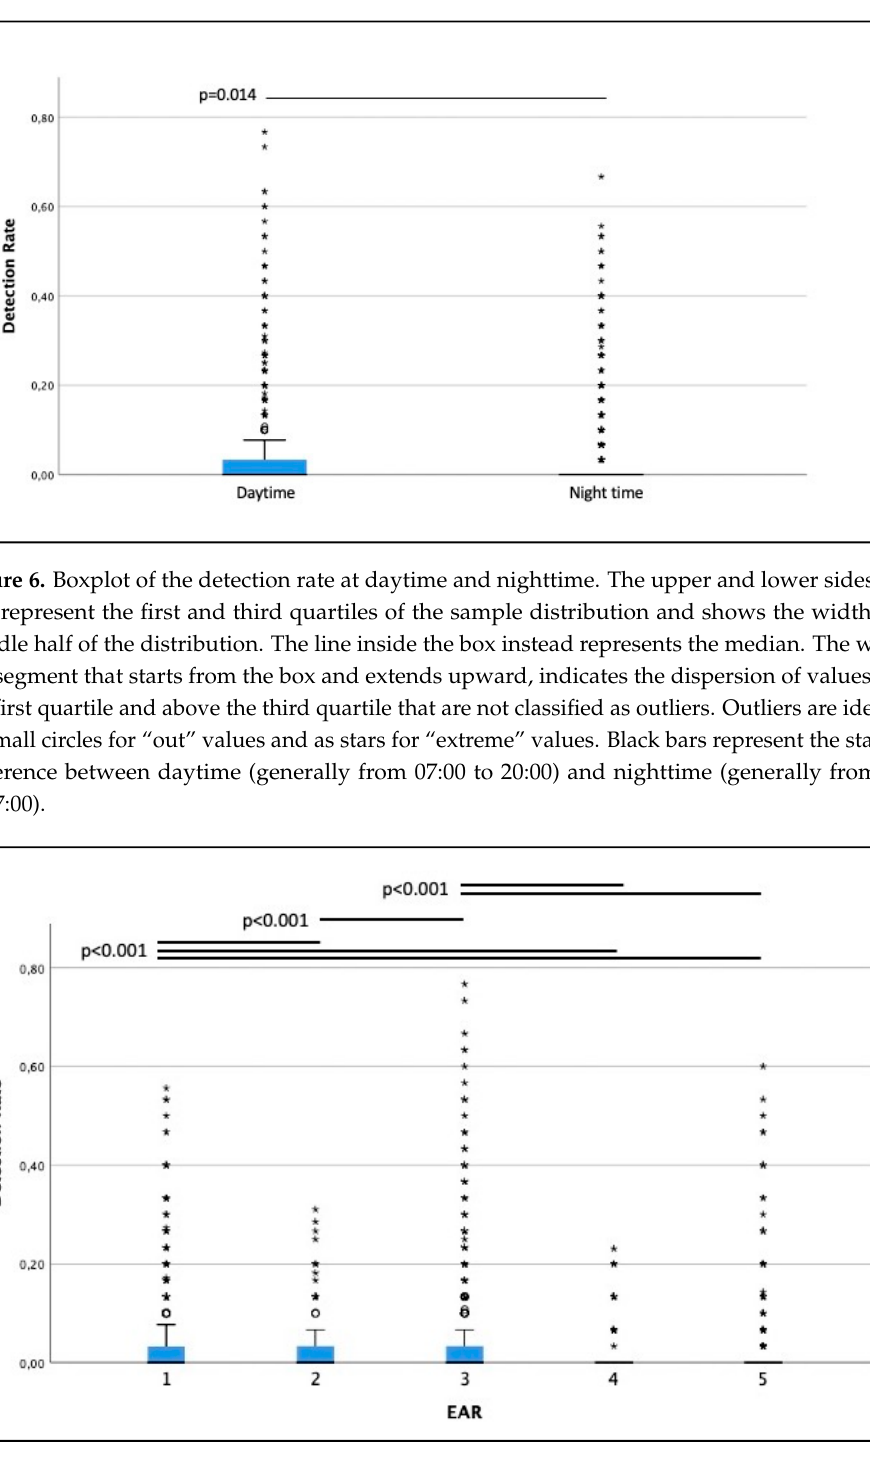
Figure 7. Boxplot of the hourly detection rate in the different EARs. The upper and lower sides of the box represent the first and third quartiles of the sample distribution and shows the width of the middle half of the distribution. The line inside the box instead represents the median. The whisker, the segment that starts from the box and extends upward, indicates the dispersion of values below the first quartile and above the third quartile that are not classified as outliers. Outliers are identified as small circles for “out” values and as stars for “extreme” values. Black bars represent significant differences between pairs of EARs.